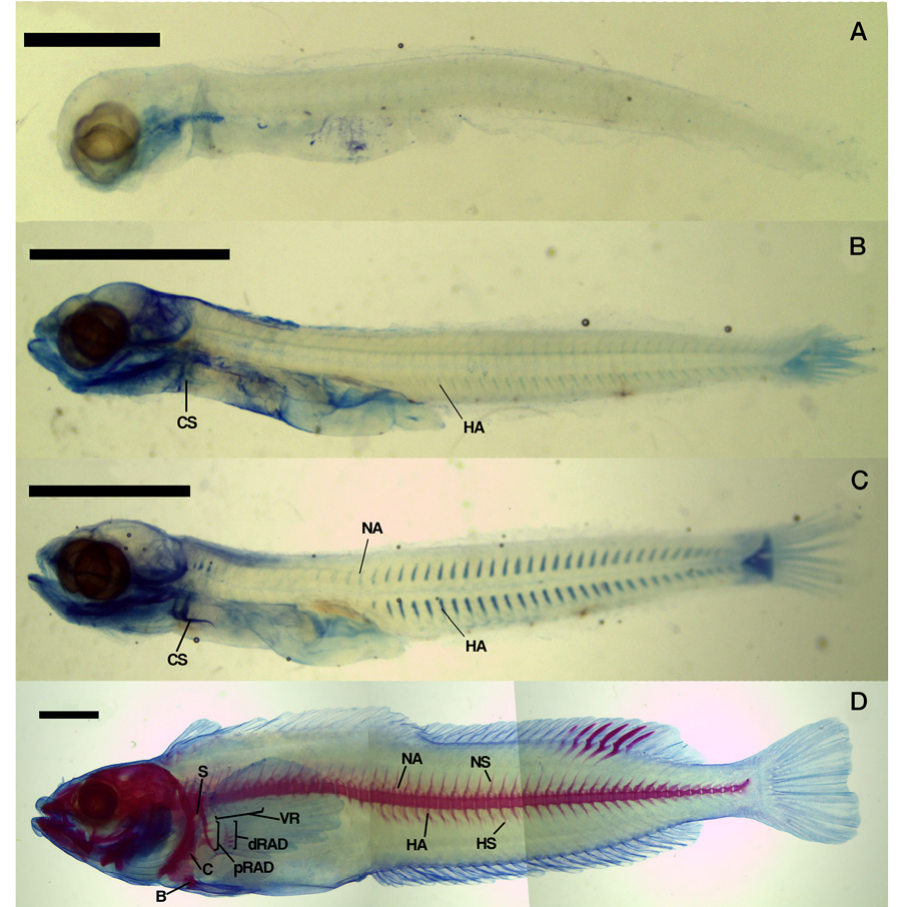
Fig. 4. – General view of cartilaginous and bony structures of 4 M. viridis individuals: Preflexion larva (A), 4.69 mm SL; late flexion larva (B), 7.17 mm SL; postflexion larva (C), 9.12 mm SL, Juvenile (D), 23.09 mm SL. CS, coracoscapular cartilage; HA, haemal arches; NA, neural arches; S, scapula; C, coracoid; pRAD, proximal radial bones; dRAD, distal radial bones; VR, ventral ribs; NS, neural spines; HS, haemal spines. Scale bars: A= 1 mm; B, C and D= 2